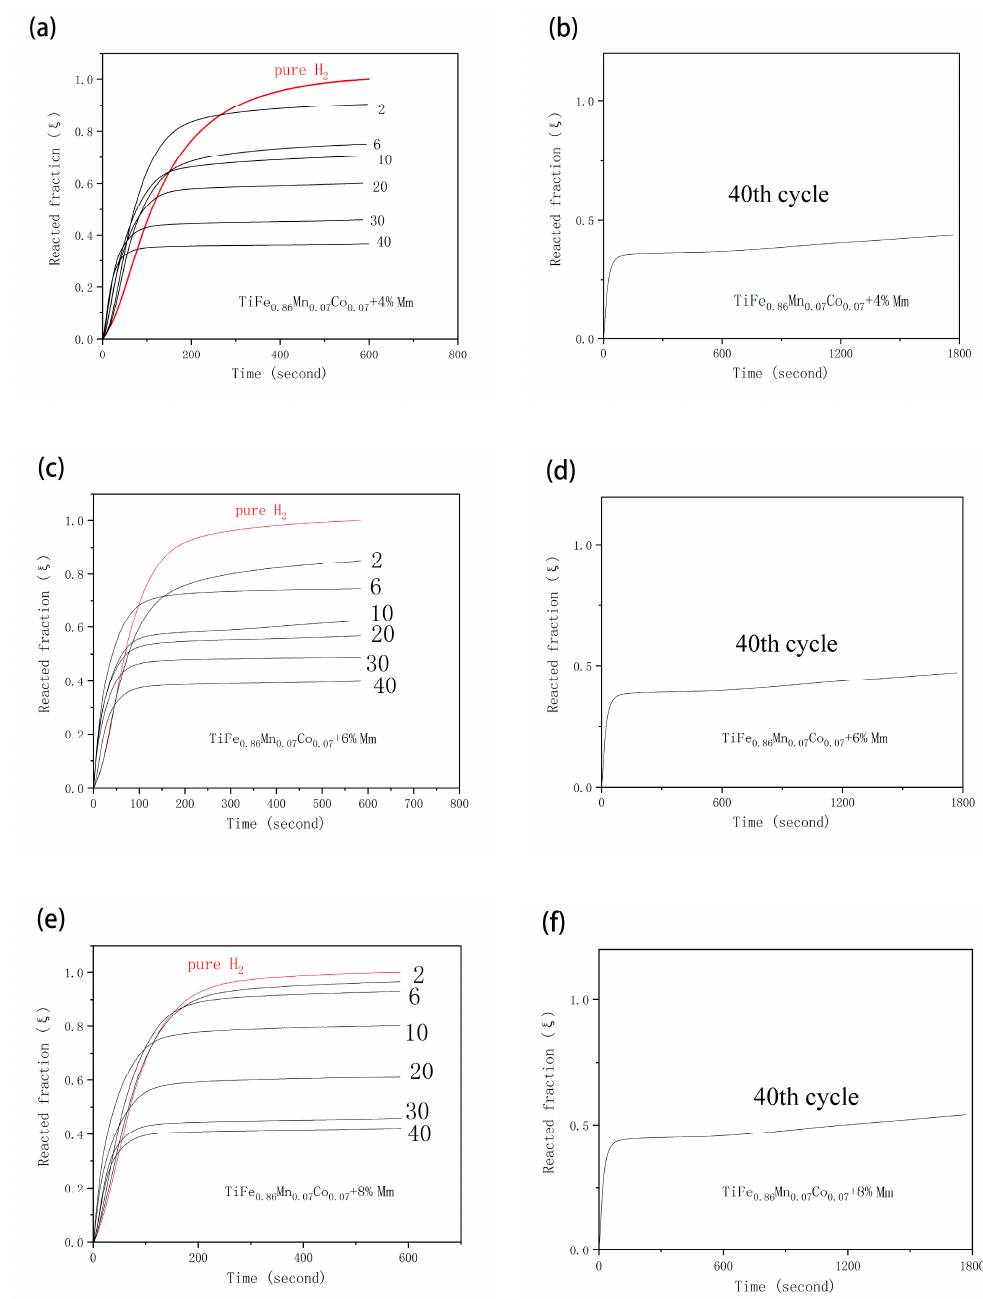
Figure 6. Hydrogen absorption kinetic curves of TiFe 0.86 Mn 0.07 Co 0.07 + x% Mm (x = 4,6,8) at 3 MPa of pure H 2 and H 2 containing 250 ppm of O 2 at 298 K. ( a , b ) TiFe 0.86 Mn 0.07 Co 0.07 + 4% Mm; ( c , d ) TiFe 0.86 Mn 0.07 Co 0.07 + 6% Mm; ( e , f ) TiFe 0.86 Mn 0.07 Co 0.07 + 8%